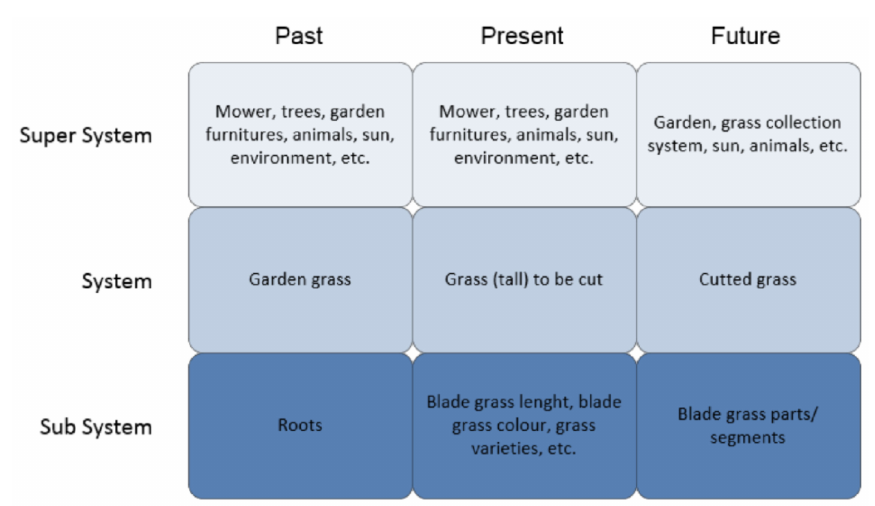
Figure A1. Classical SO for the example considered in Section